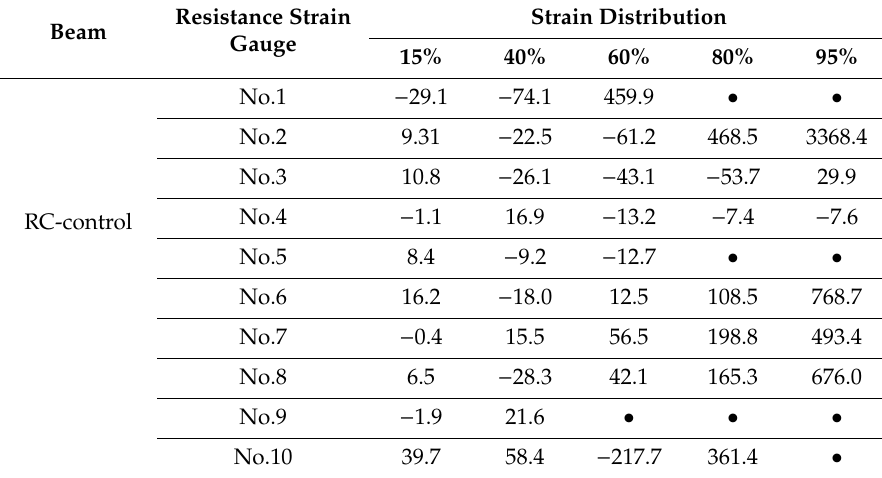
Table 8. Strain distribution of concrete for RC-control beam.